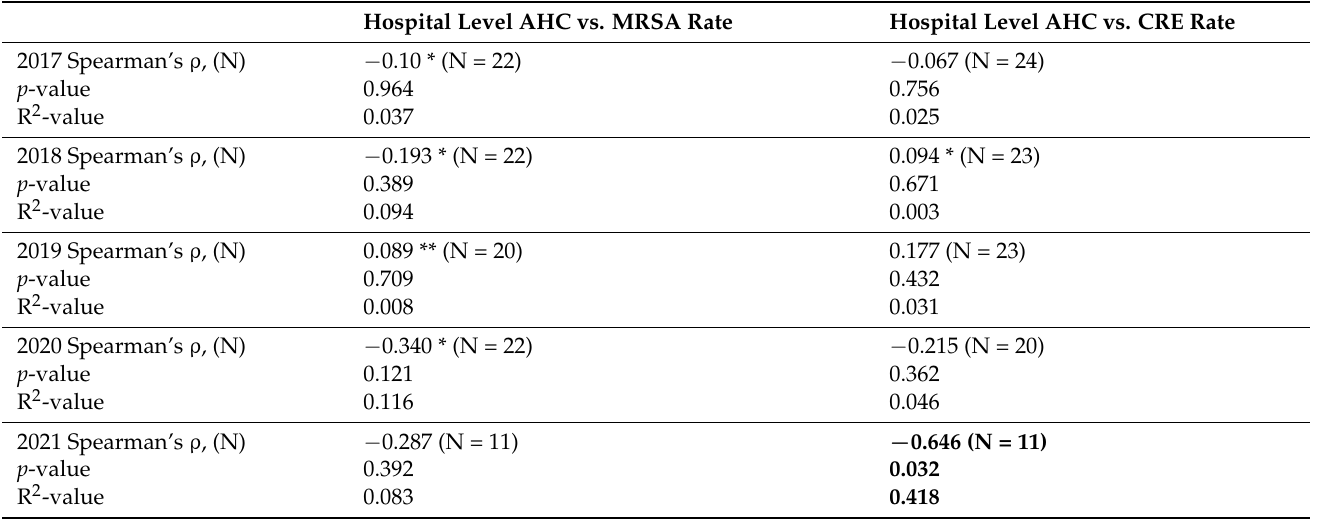
Table 2. Correlation between alcohol-based handrub consumption (AHC), and methicillin-resistant Staphylococcus aureus (MRSA) and carbapenem-resistant Enterobacteria (CRE) rates at the hospital level.